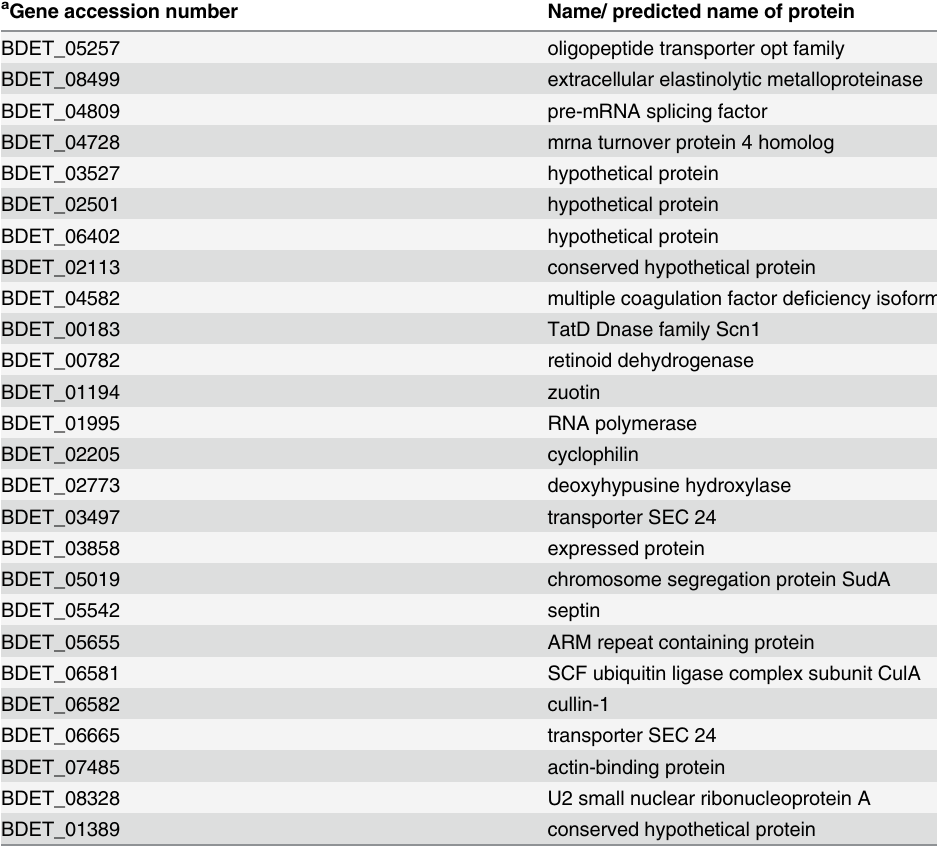
Table 4. List of uniquely present proteins in Bd exposed to methanol